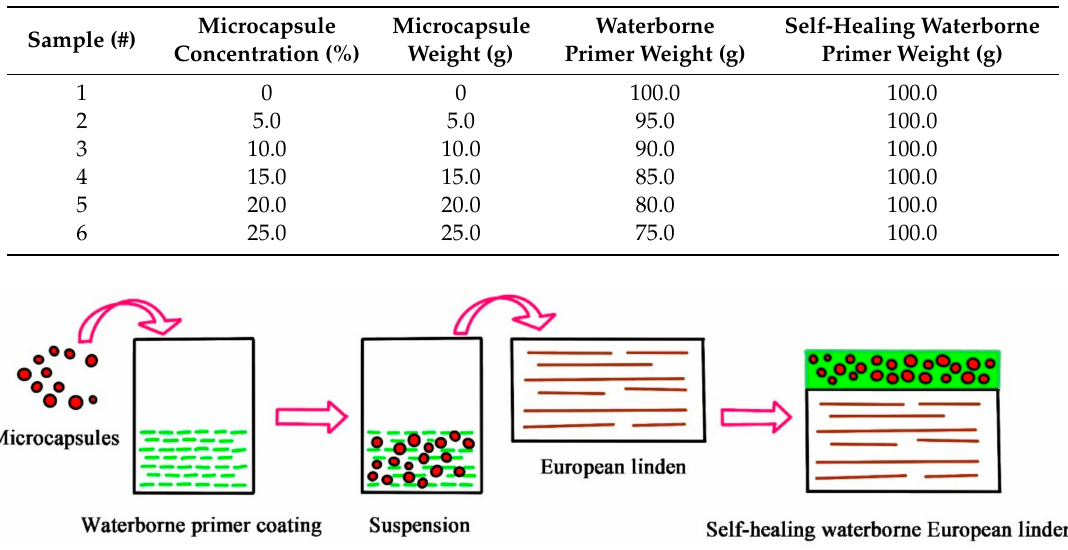
Figure 1. Preparation route of self-healing coatings and self-healing mechanism of waterborne coatings with microcapsules on European